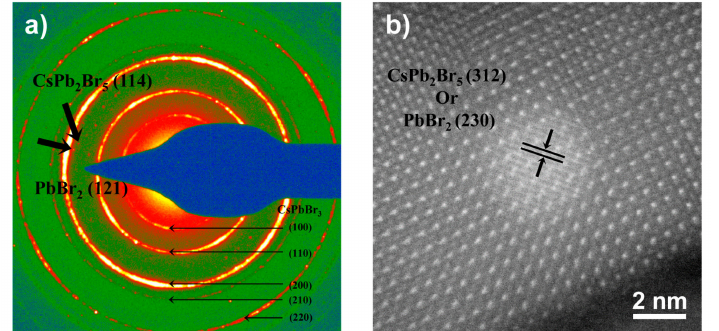
Figure 2. ( a ) SAED pattern of the NPs on the CsPbBr 3 NCs. Arrowed spots can be identified as PbBr 2 NPs and CsPb 2 Br 5 NPs, excluding the main diffraction rings belonging to various CsPbBr 3 planes. ( b ) High-resolution STEM-HAADF image of a CsPb 2 Br 5 NP (a PbBr 2 NP is also possible) formed on the CsPbBr 3 NC (CsPbBr 3 , cubic phase, PDF#75-0412; PbBr 2 , orthorhombic phase, PDF#31-0679; CsPb 2 Br 5 , tetragonal phase, PDF#25-0211).